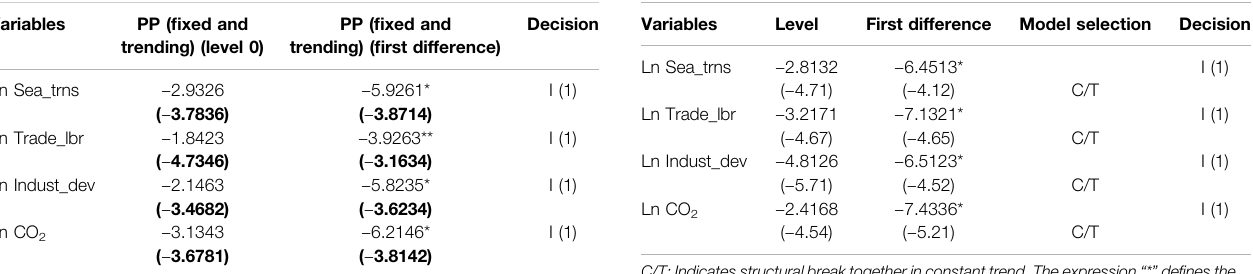
C/T:Indicatesstructuralbreaktogetherinconstanttrend.Theexpression “ * ” de fi nesthe unit root test results for the variables used in the estimation process for 1% signi fi cance level. Statements in parentheses are 1% signi fi cance, respectively. It shows the critical valueandstructuralbreakdatesforthelevel.The fi ndingsdemonstratethatthevariables used in the model are stationary I(1) in the fi rst